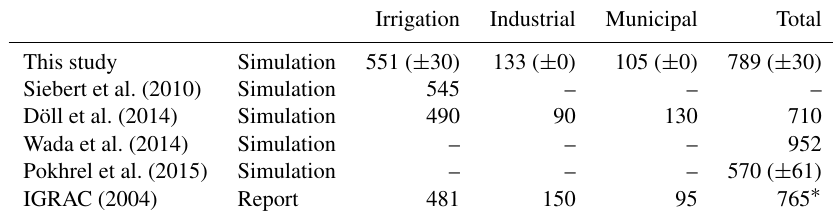
Table 3. Global total groundwater abstraction by sector. Unit: km 3 yr − 1